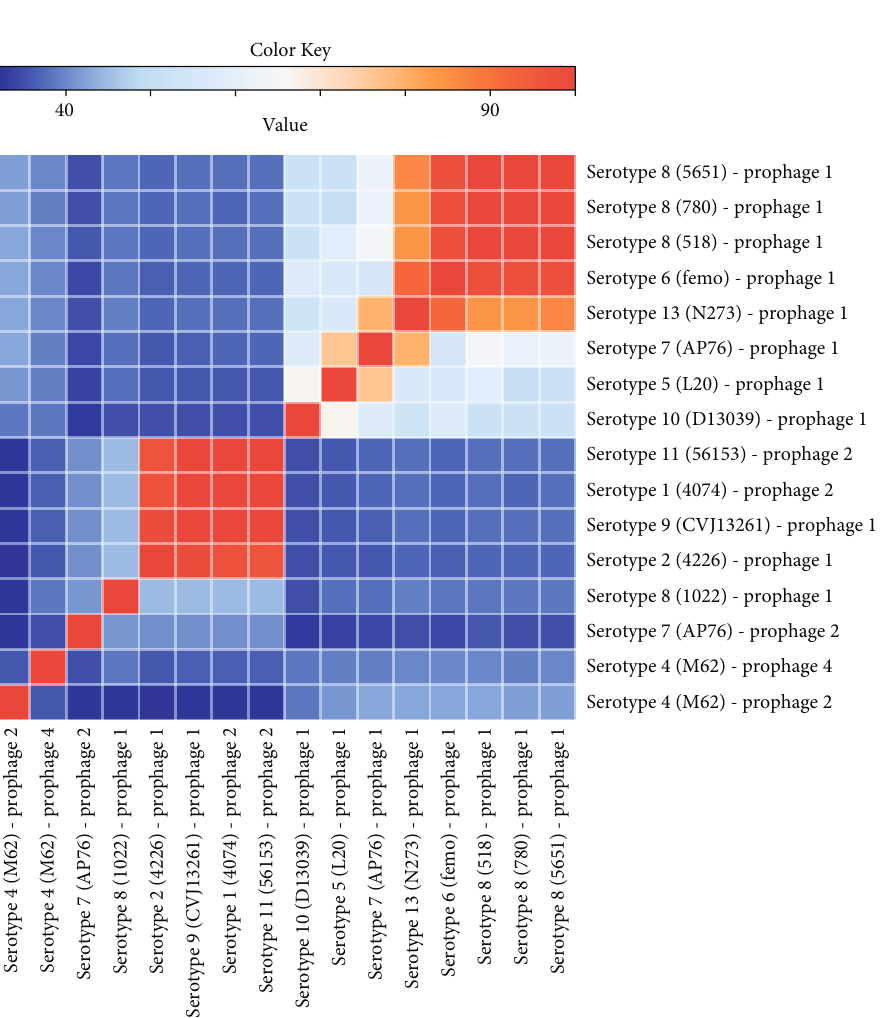
Figure 5: Heat map analysis from identity matrix generated by global alignment of 16 complete prophage genomes. The alignment was done using Clustal Omega, and the identity matrix generated was used to create the heat map by R